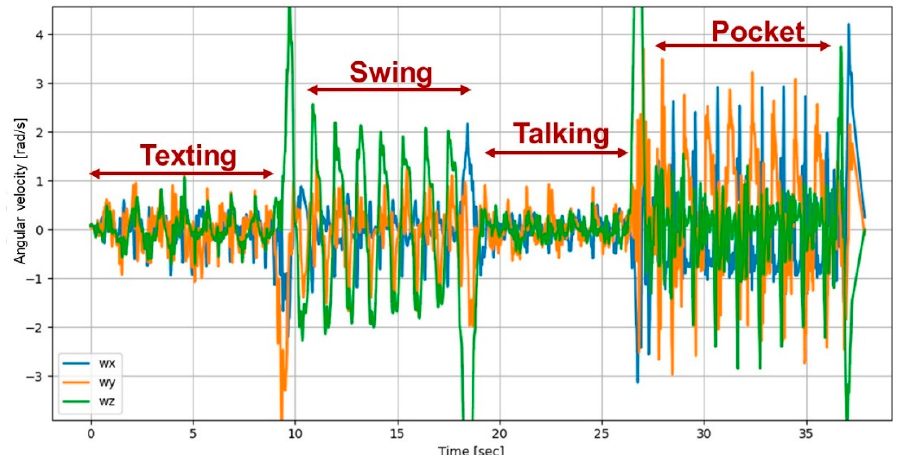
Figure 3. Angular velocity vector as recorded during four smartphone locations: texting, swing, talking, and pocket.